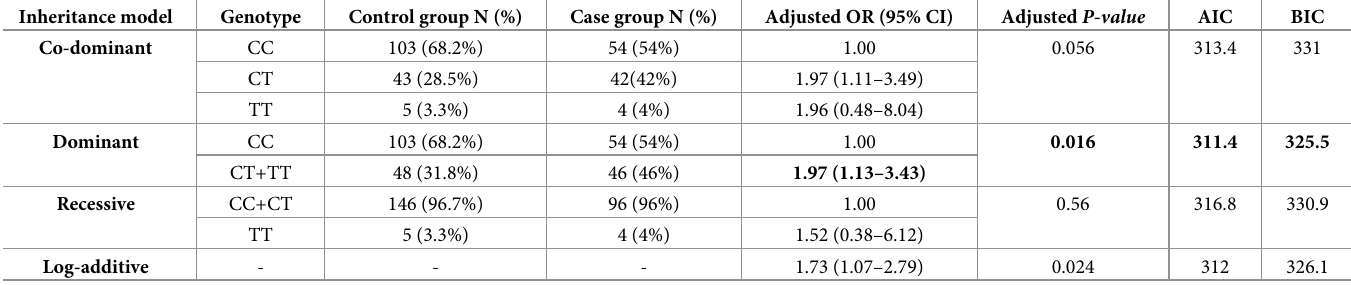
Table 3. Analysis of TMPRSS2 genotypes association with COVID-19 disease severity under five different inheritance models adjusted by gender and age. Adjusted P-values, adjusted odds ratio (OR), 95% confidence intervals (95% CI), AIC and BIC.